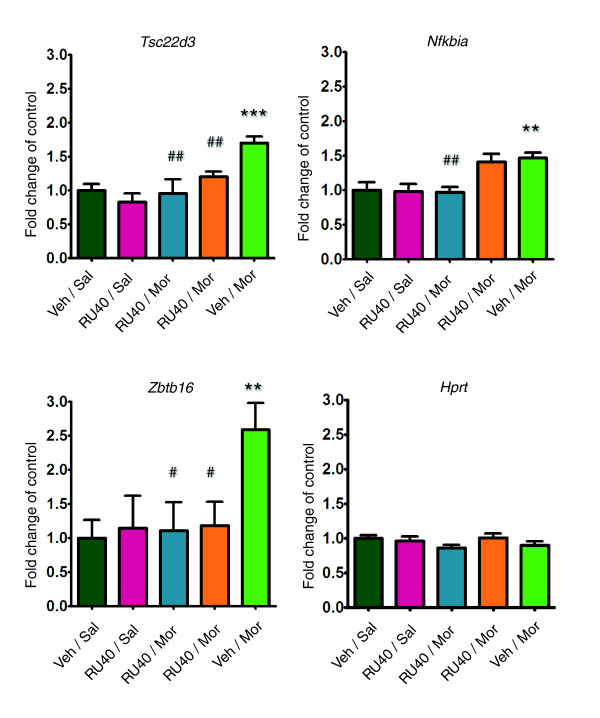
Involvement of glucocorticoid receptor in transcriptional response to morphine. Inhibition of morphine-induced transcription of selected genes by an antagonist of the glucocorticosteroid receptor, namely RU486. Five experimental groups were compared (see Materials and methods): vehicle and acute subcutaneous morphine 20 mg/kg (Veh/Mor); morphine preceded by injection of 20 mg/kg RU486 (RU20/Mor); morphine preceded by injection of 40 mg/kg RU486 (RU40/Mor); and control groups injected with saline and RU486 (RU40/Sal) or saline and vehicle (Veh/Sal). Gene expression in striatum of C57BL/6J mice was analyzed 4 hours after morphine treatment. The results of quantitative real-time reverse transcription polymerase chain reaction (qPCR) are presented as fold change of control group (Veh/Sal) with standard error. Differences between groups were analyzed by analysis of variance ANOVA following Bonferroni multiple comparison correction (n = 5 to 6; **P < 0.01, ***P < 0.001 versus control group; #P < 0.05, ##P < 0.01 versus morphine).